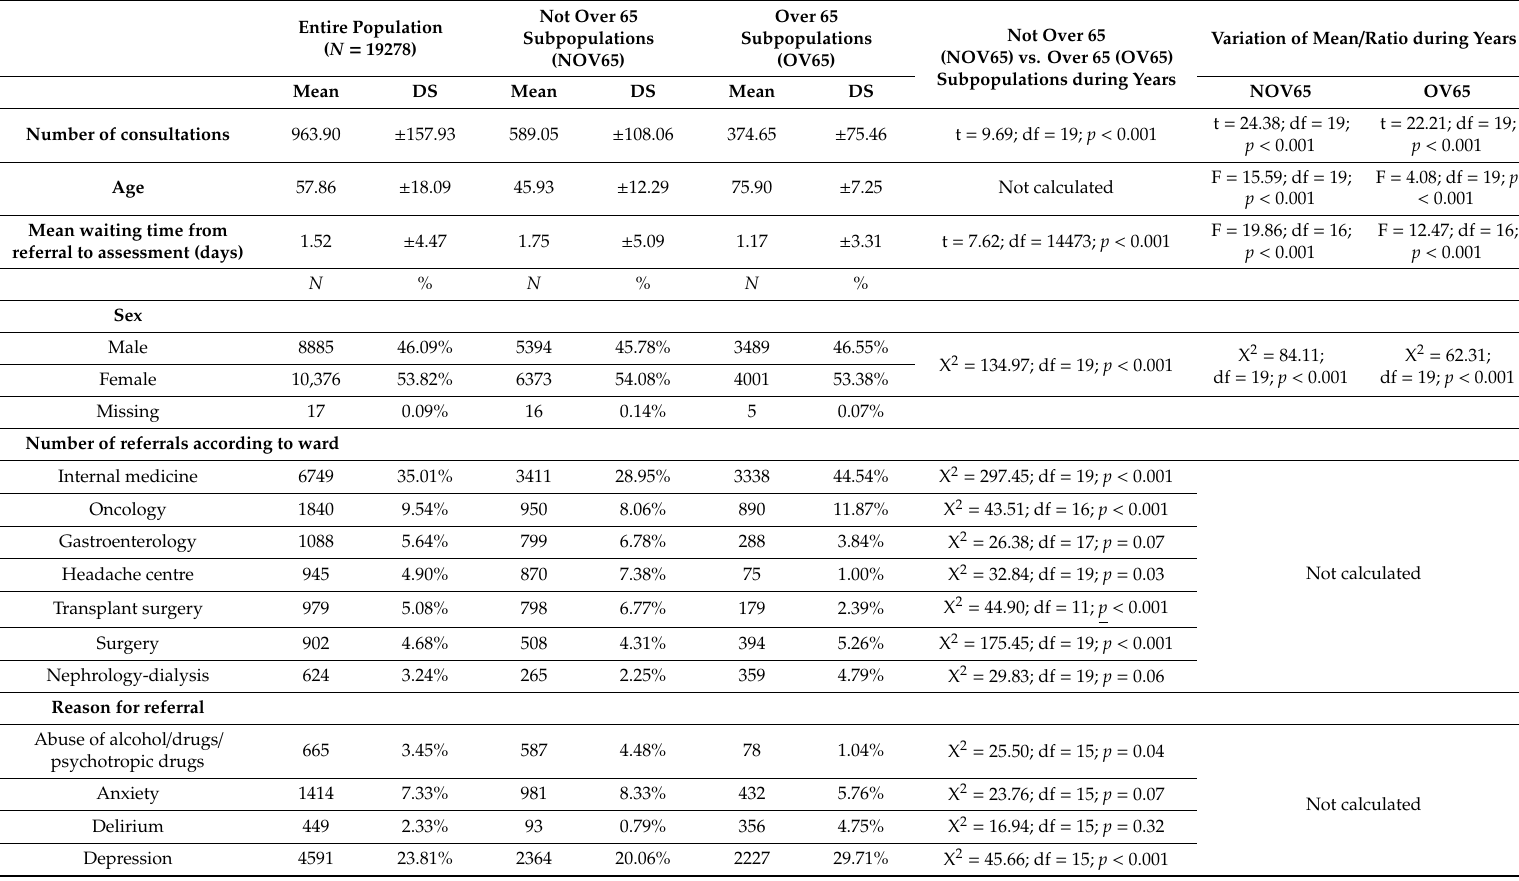
Table 1. Descriptive analysis of the collected clinical and sociodemographic